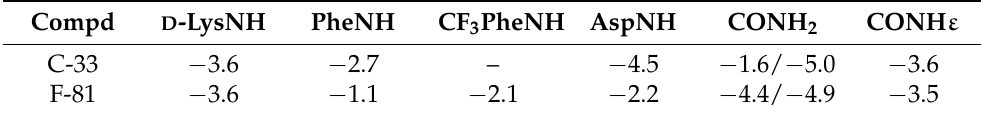
Table 3. ∆ δ / ∆ t (ppb/K) values for peptides F-81 and C-33 in DMSO- d 6 .